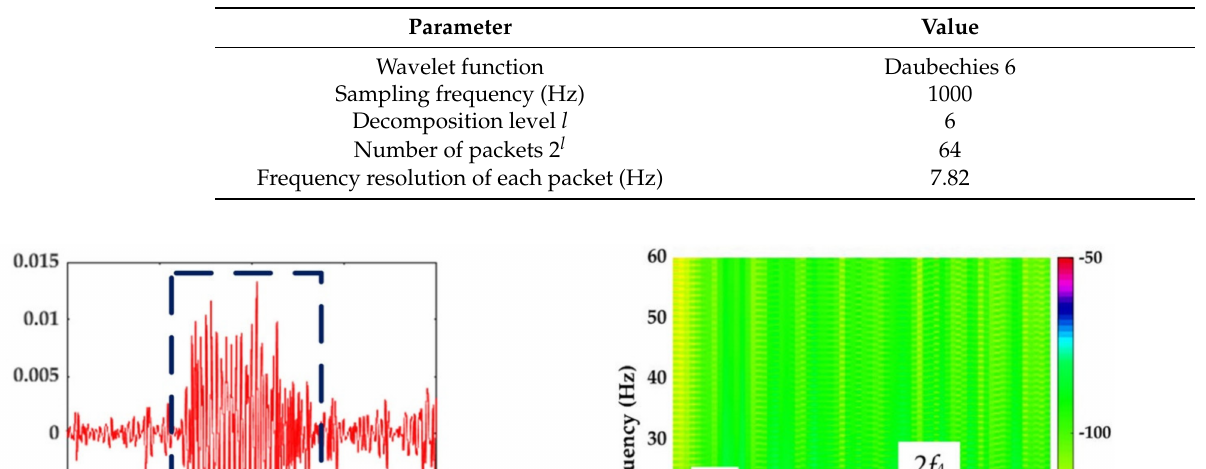
Table 1. Wavelet function, decomposition level, and frequency parameters.